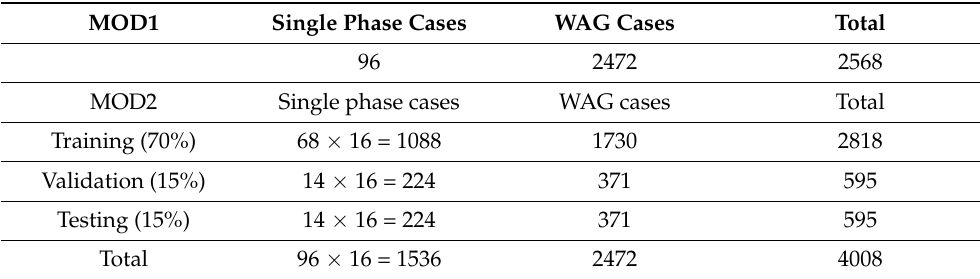
Table 1. Number and type of points in different datasets and models.